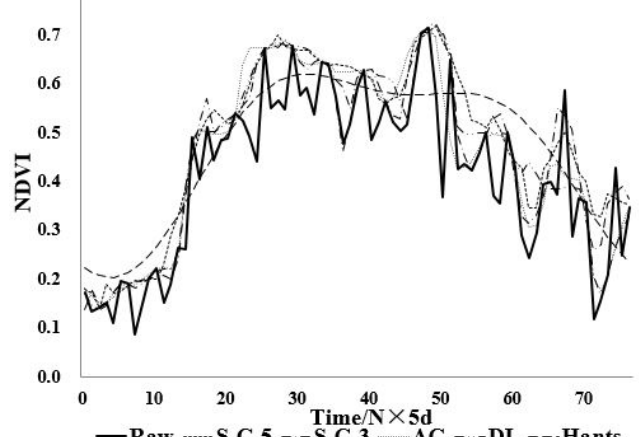
Fig. 3: The original and filtering curves for mixed tree sample points The NDVI time series of five typical vegetation types, corresponding to the five points mentioned in section II, are constructed. For the pure vegetation pixel points, the mean NDVI values of all vegetation types increases after filtering, as shown in Fig. 4(a). According to the comparison results, the increasing extent of S-G with sliding window size of 5 (S-G 5) is most significant. In addition, the increasing extent of NDVI values after filtering for the evergreen coniferous tree, deciduous tree, evergreen and deciduous broad-leaved mixed tree, shrub and grassland increased rate are 16%, 14%, 14%, 12%, and 9% respectively. The reason can be explained by the characteristics of NDVI value of trees, shrubs and grasslands as well as the principles of filters. Under normal circumstances, the mean NDVI values of trees is larger than those of shrubs and grasslands, while the intensity of the noise does not vary with the NDVI values. The larger the original NDVI values, the Table 3 Parameters setting for different filters smaller the absolute value of the deviation. For the filters, they are subject to repair the reduction introduced by ground water, snow-covered ground, clouds and aerosols and so on